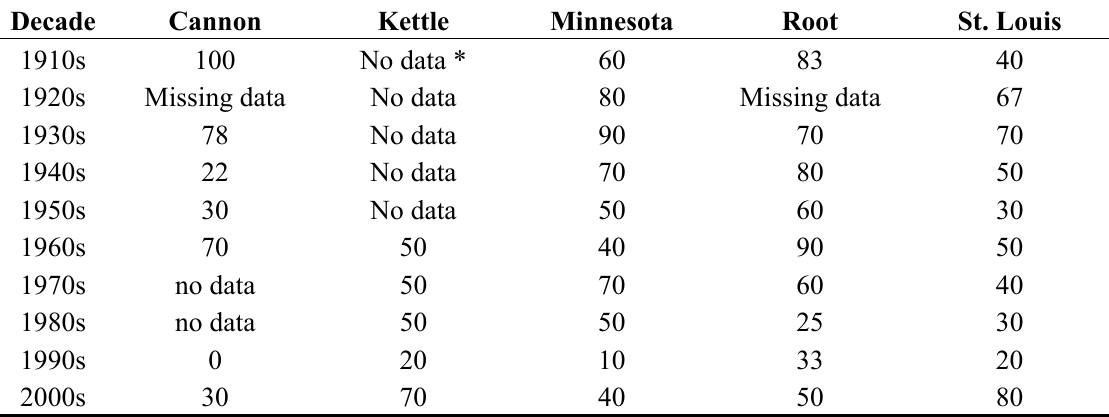
Table 4. Percentage of years with suitable water levels for riverine turtle nesting on sandbars during June and July by decade as predicted by stage-sandbar emergence relationships developed for this study. Suitable nesting conditions on sandbars are defined as having at least 75 consecutive days of exposed sandbar conditions for nesting, development and incubation of eggs, starting by June 1 but no later than 15 August. Sandbar-submerging flows of one day were considered non-lethal, but two or more consecutive days of flooding are considered lethal to developing turtle